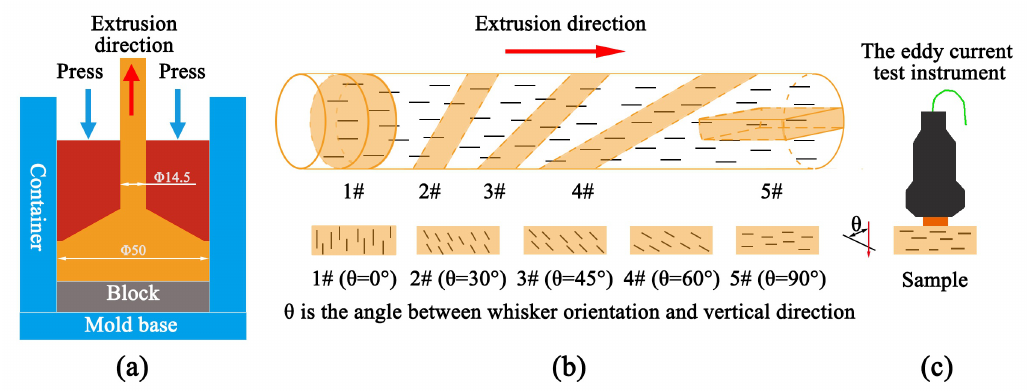
Figure 2: Schematic diagram: (a) the extrusion process experimental set-up, (b) extruded billet and samples, (c) electrical conductivity measurement method